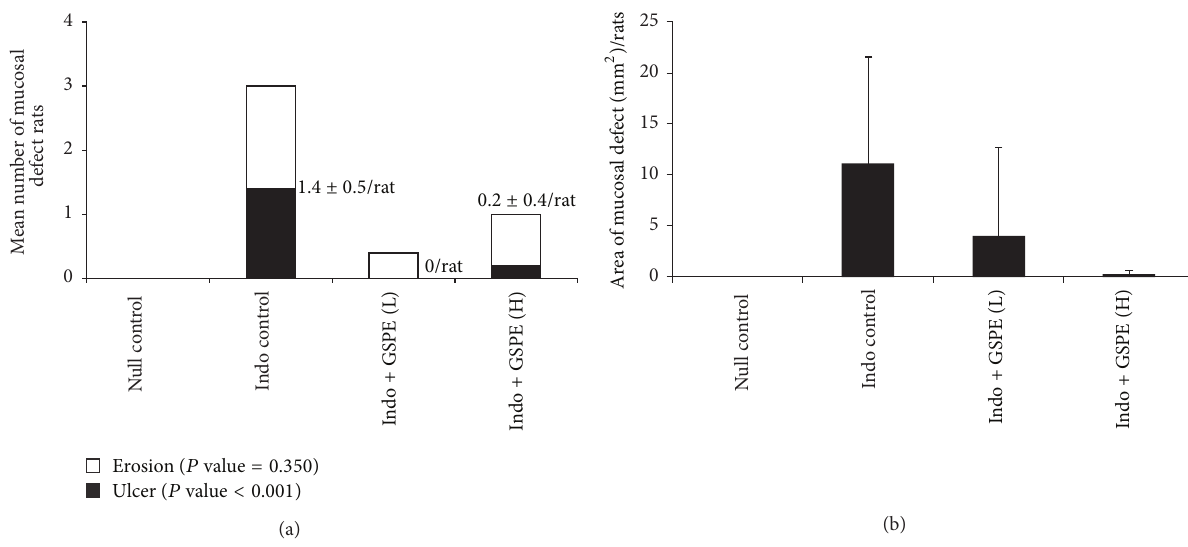
Figure 5: Areas and numbers of ulcers and erosions. (a) The mean number ± SD of ulcers was 1.4 ± 0.5 /rat in the indomethacin control group, zero in the GSPE low-dose group, and 0.2 ± 0.4 /rat in the GSPE high-dose group ( 𝑃 value < 0.001 ). The number of erosions was not significantly different among the treatment groups. (b) The mean area ± SD of mucosal defects was 11.1 ± 10.5 mm 2 /rat in the indomethacin control group, 3.9 ± 8.7 mm 2 /rat in the GSPE low-dose group, and 0.3 ± 0.4 mm 2 /rat in the GSPE high-dose group.